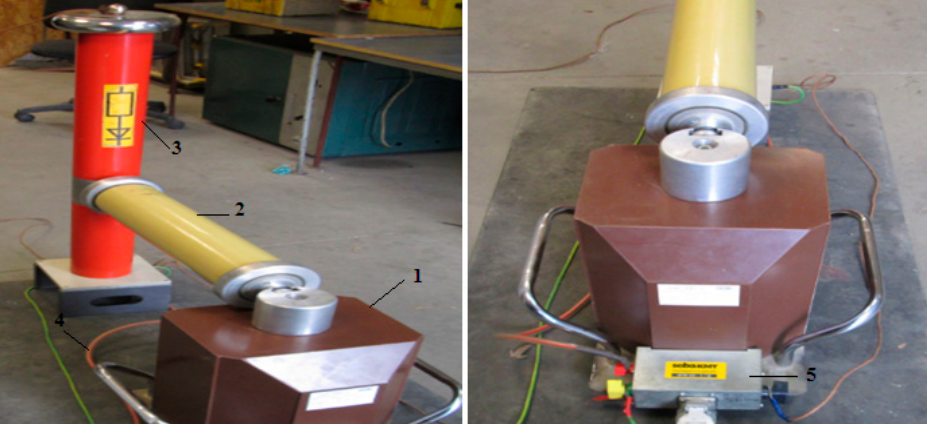
Figure 1. High-voltage test installation type HPG 70 D: (1) IT transformer; (2) Capacitor coupling and multiplication; (3) Multiplier rectifier diodes; (4) Connection cables; (5) Connection box.